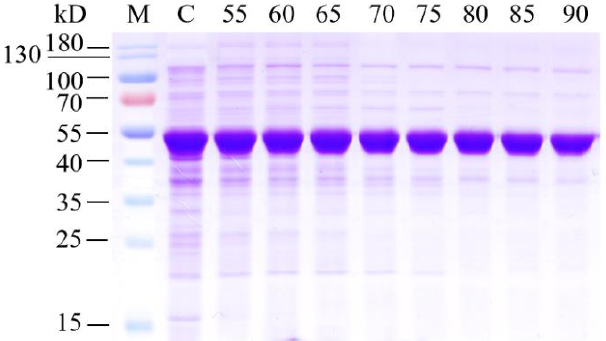
Figure 1. Analysis of heatpurified fumarase using sodium dodecyl sulphate–polyacrylamide gel electrophoresis. Lane M, pre-stained protein molecular weight marker; lane C, crude cell extract without heat treatment; lanes 55–90, supernatant after heat treatment at 55–90 °C. The thick band at 50 kDa corresponds to the overexpressed fumarase.